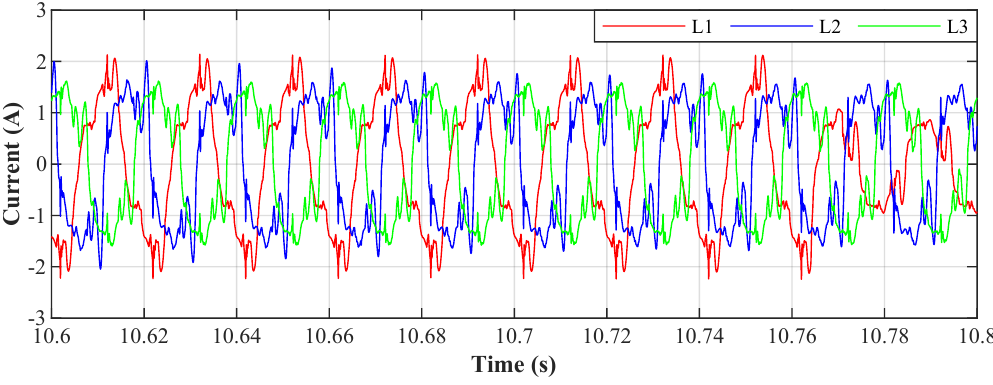
Figure 28. Switched on test polygon; current waveforms before